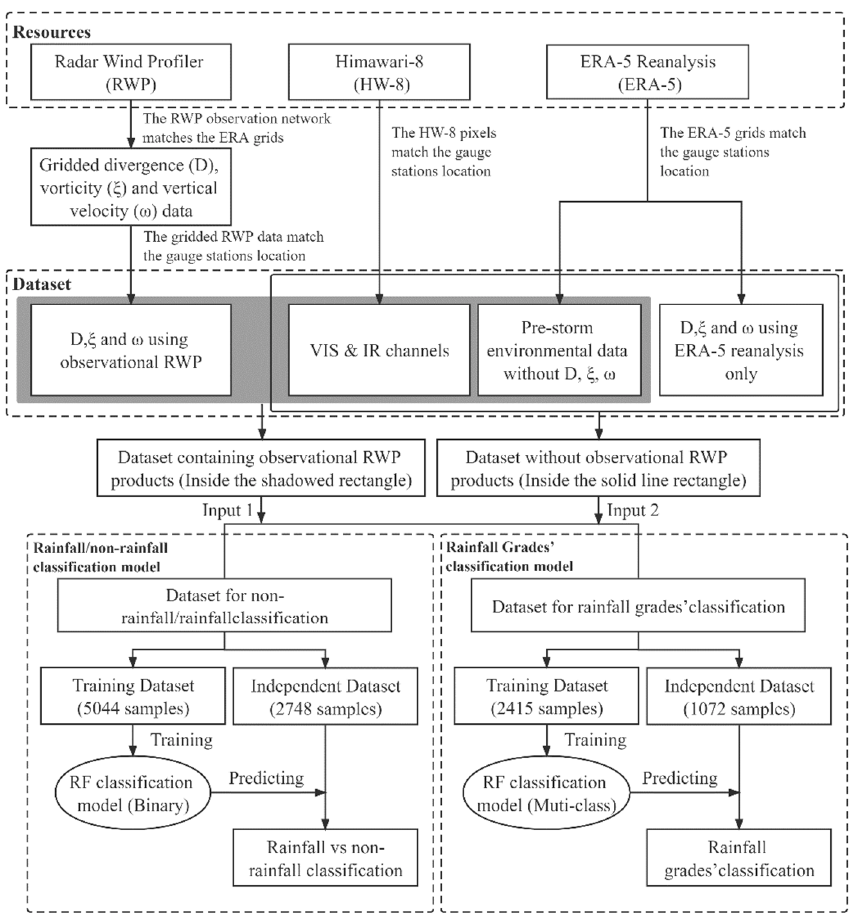
Figure 3. Flow chart of random forest model establishment and training.